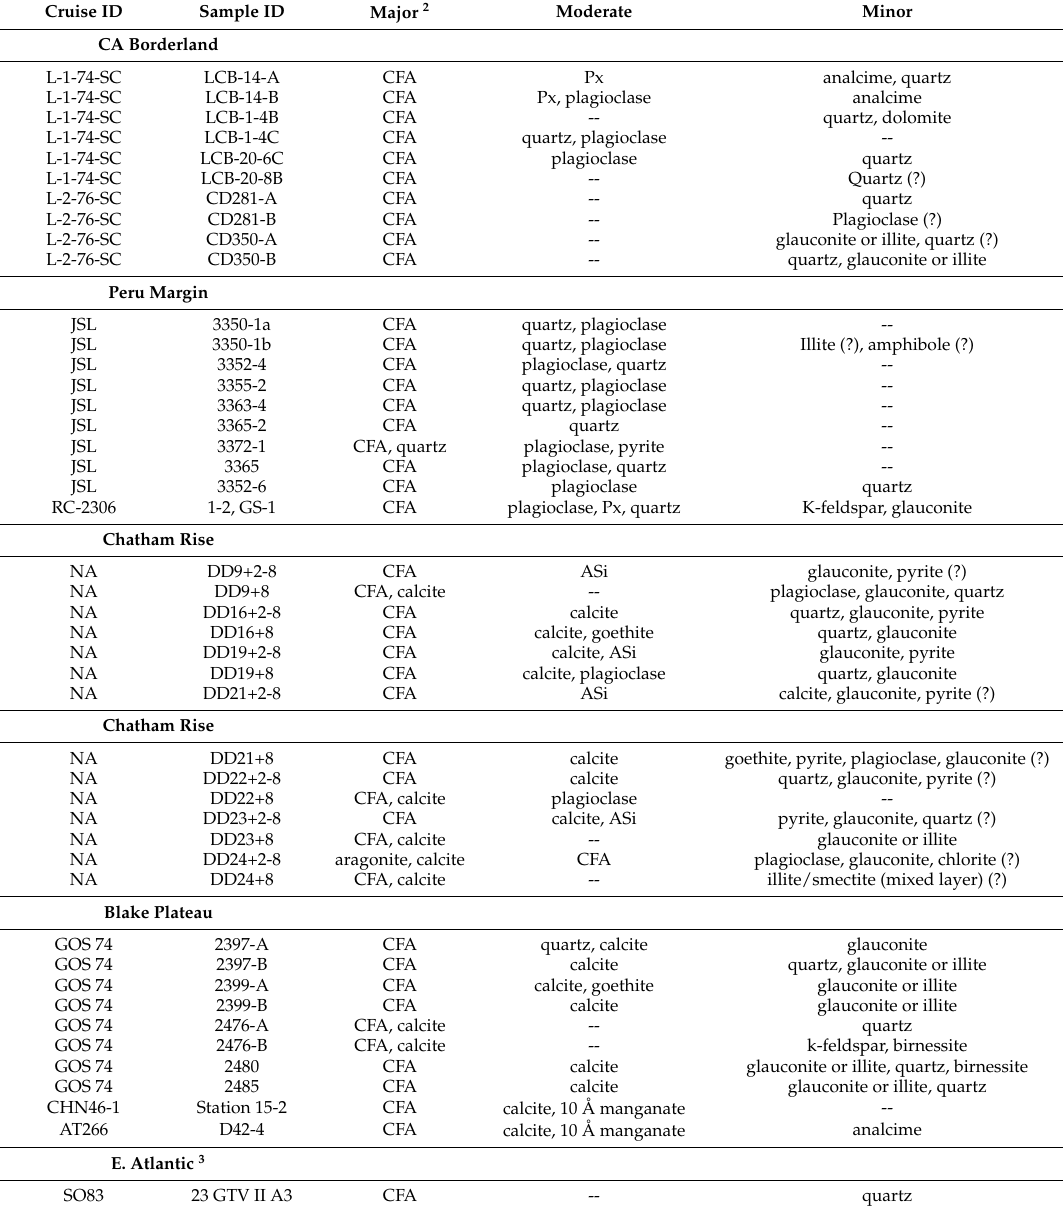
Table 2. XRD Mineralogy of phosphorites from continental margins 1